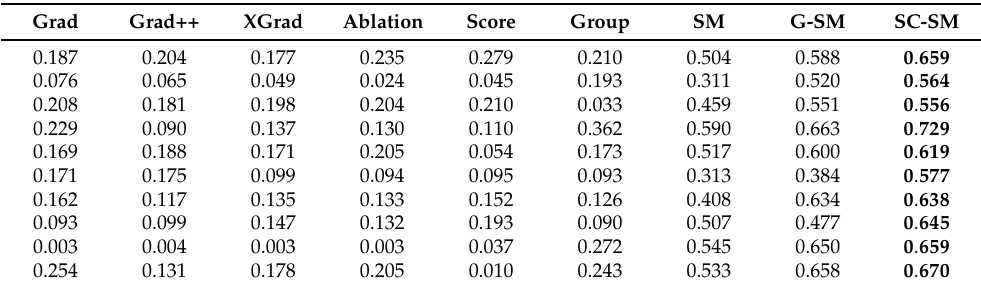
Table 1. IoU for the SAR images and heatmaps. Each row corresponds to an original SAR image from the first to the tenth row in Figure